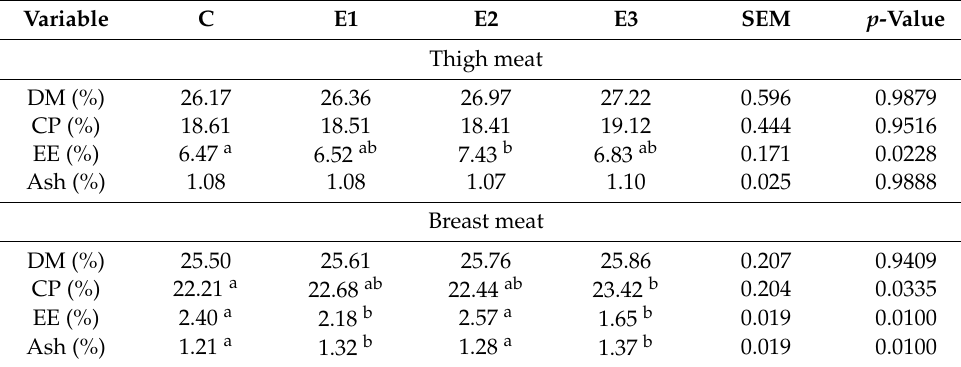
Table 3. Proximate composition of thigh and breast meat